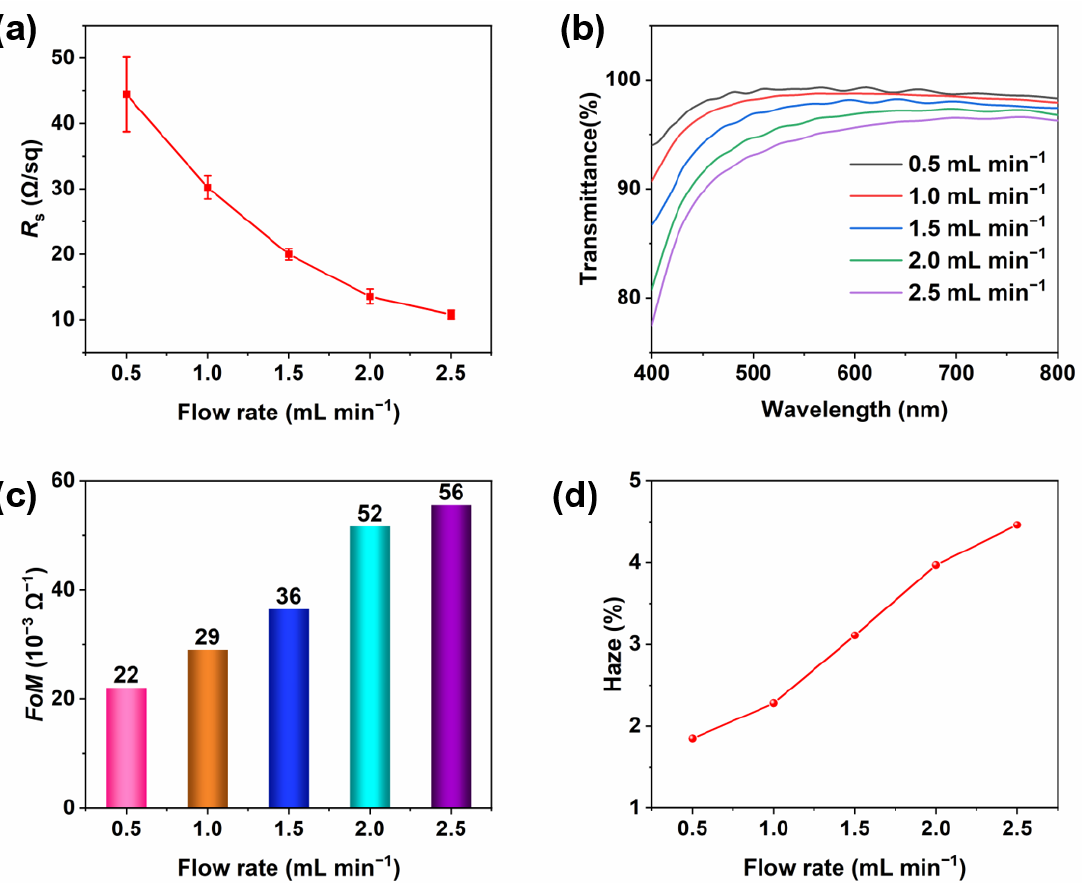
Figure 2. Optoelectronic properties of the AgNW film produced at different flow rates: ( a ) the R s of the AgNW films; ( b ) the transmittance of the AgNW films from 400 nm to 800 nm; ( c ) the FoM ; ( d ) the haze values of the AgNW films.